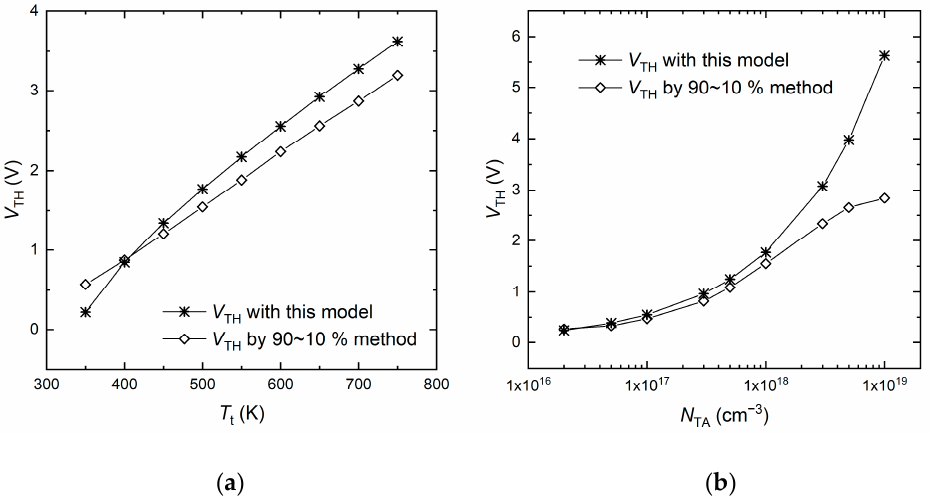
Figure 3. Transfer characteristics ( V DS = 0.1 V) under various tail states ( a ) T t ( N TA = 1 × 10 18 cm − 3 ) and ( b ) N TA ( T = 500 K), with extracted V TH marked in the figures.